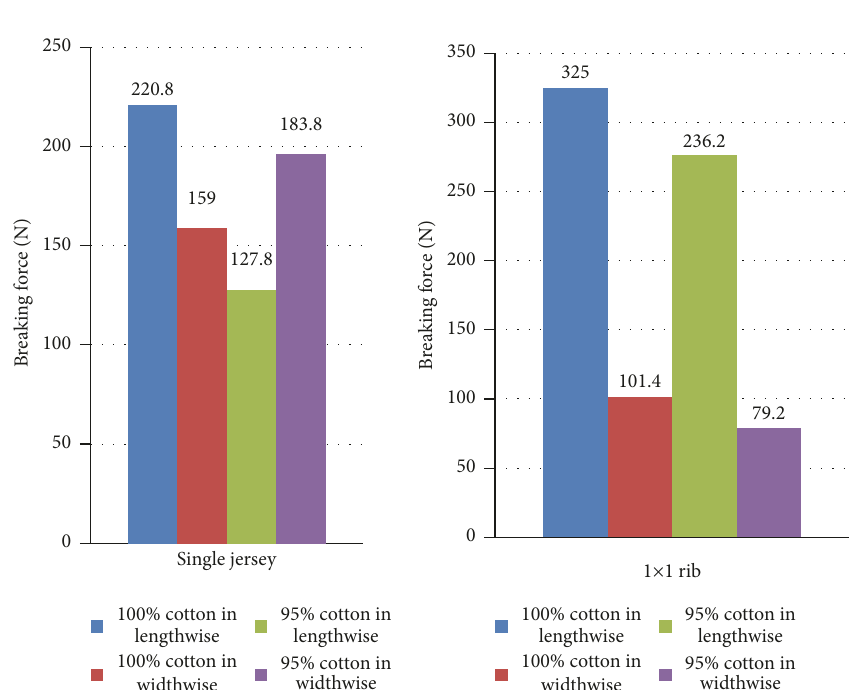
Figure 1: Tensile strength of single jersey and 1 × 1 rib knitted